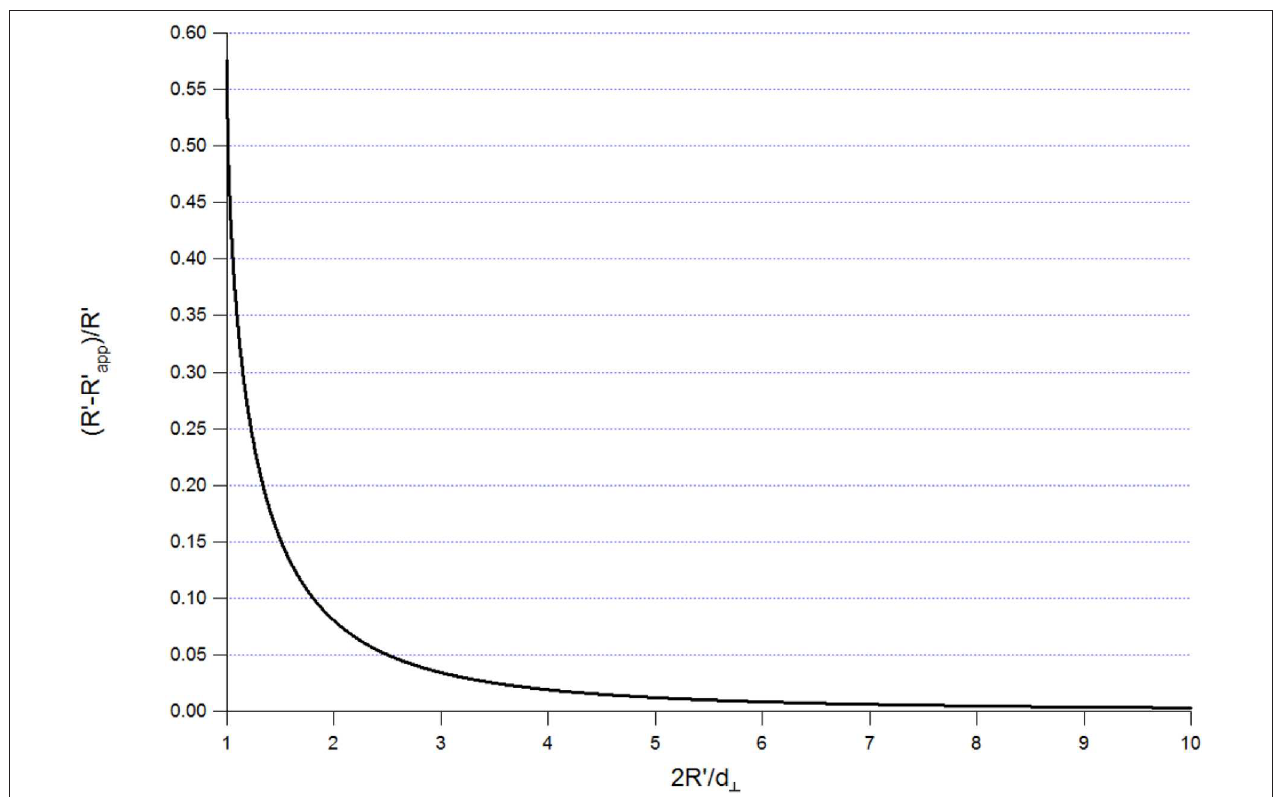
FIGURE 4 | Relative error in the calculation of R ′ by using the approximation in Equation (6) over the ratio of twice the radius of curvature R ′ to the track width d ⊥